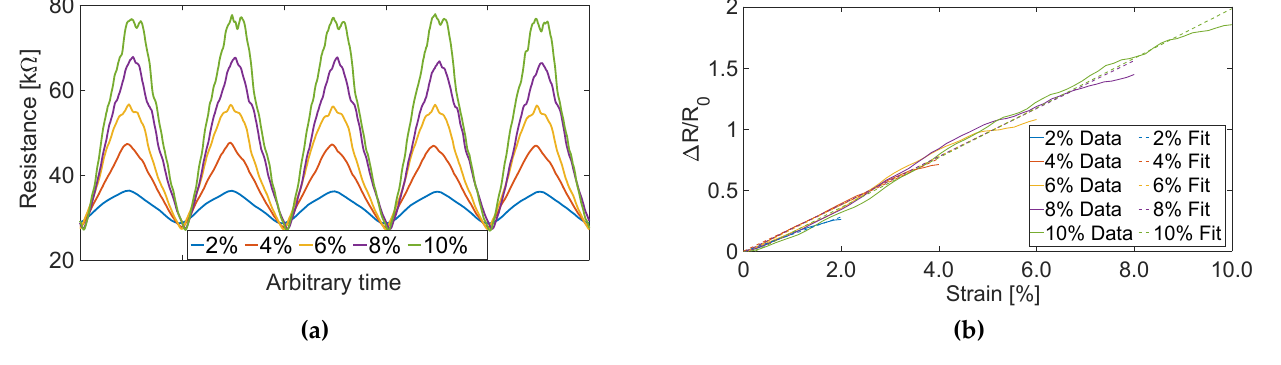
Figure 7. ( a ) Motion Tape resistance time history measurements with different peak strains (from 2% to 10%) show its stable and repeatable sensing response. ( b ) Linearity was confirmed by fitting linear Arbitrary time least-squares regression lines (dashed lines) to the normalized change in resistance data (solid lines) with respect to the applied